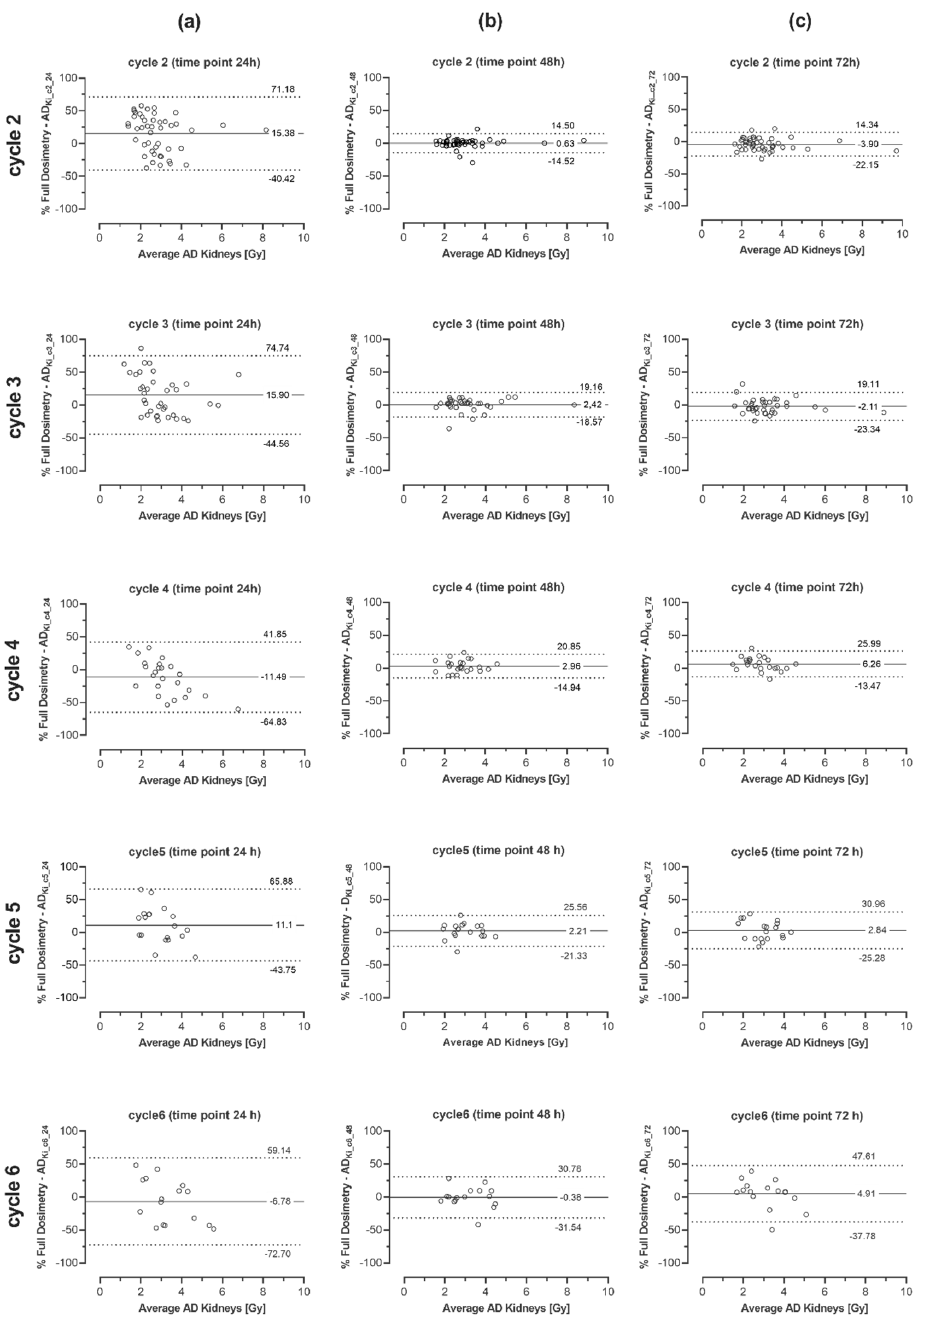
Figure A1. Bland-Altman Analysis comparing calculated absorbed doses of the kidneys using full dosimetric scheme (method 1, used as reference) and streamlined dosimetry (method 2) for therapy cycles 2 to 6 and each single time-point imaging at 24 ( a ), 48 ( b ) and 72 h p.i. ( c )